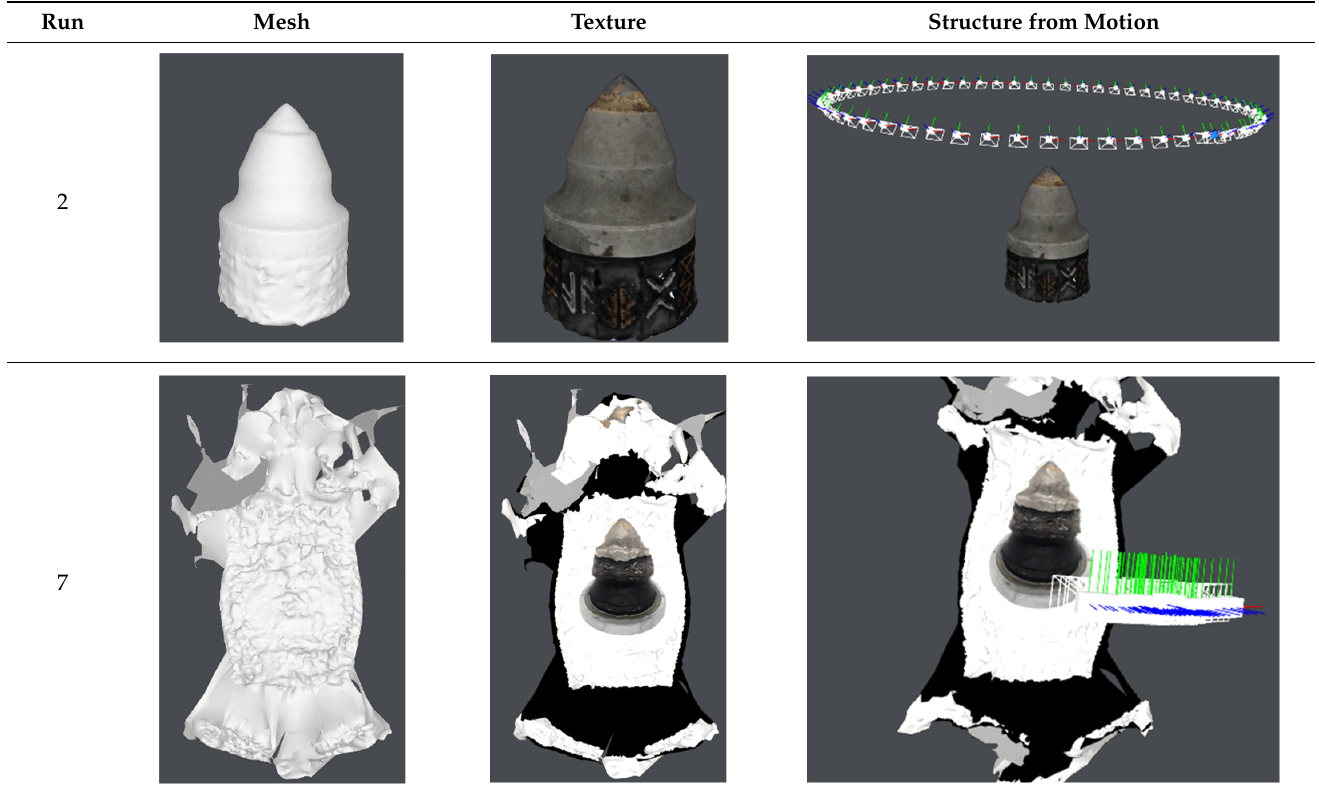
Table 5. Properly projected geometry, f = 2.525; improperly projected geometry, f = 1.126.